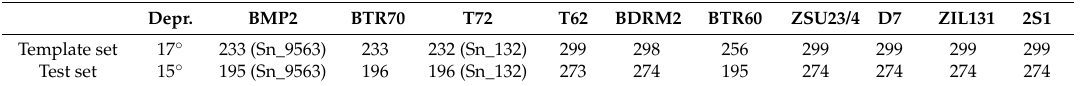
Figure 7. Optical images of the 10 military targets. ( a ) BMP2; ( b ) BTR70; ( c ) T72; ( d ) T62; ( e ) BRDM2;